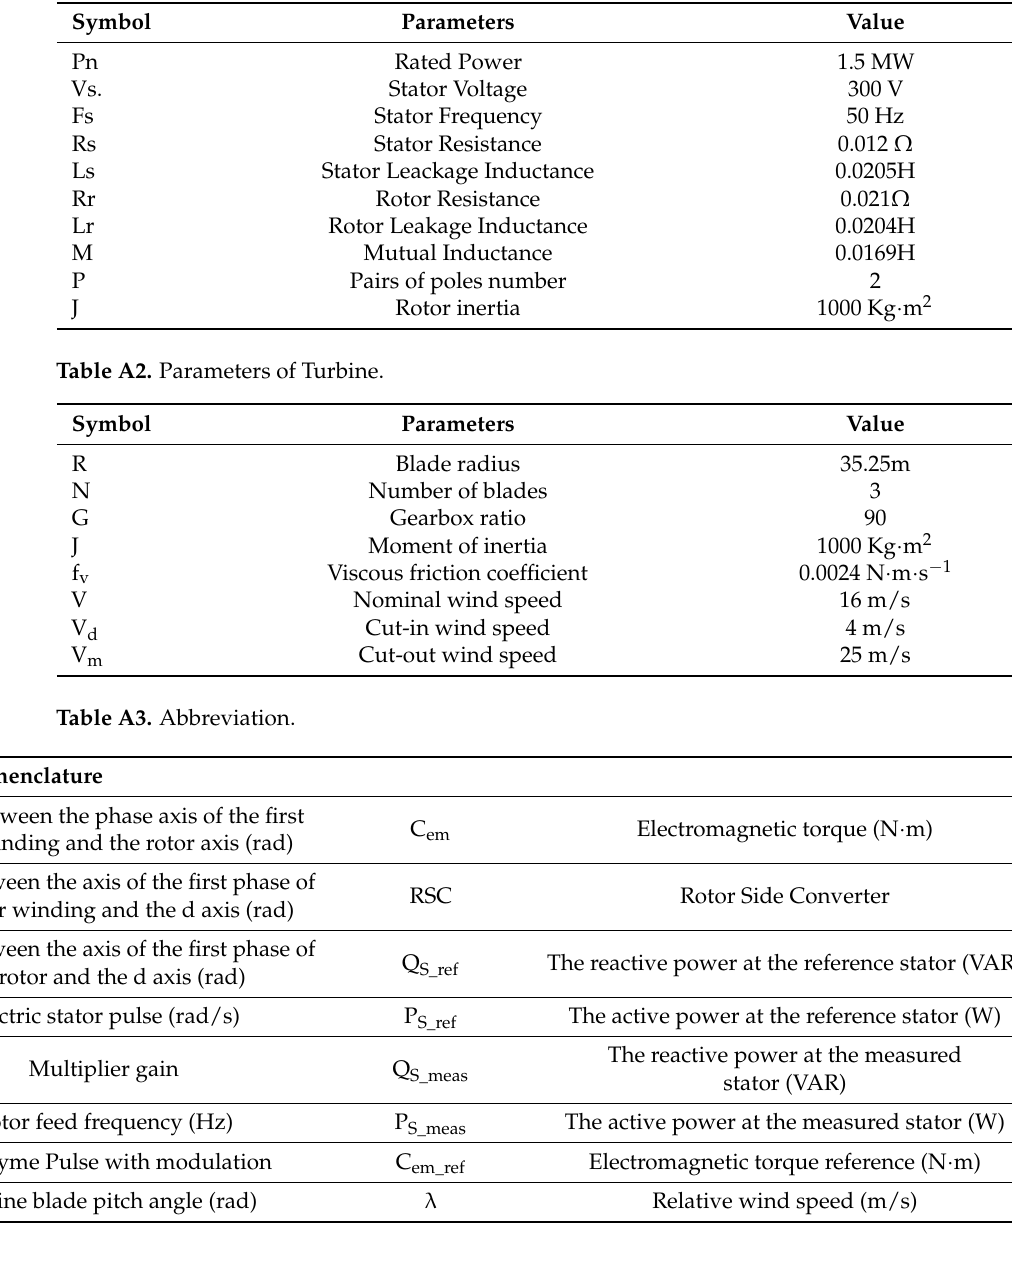
Table A1. Parameters of 1.5 MW doubly fed induction generator.